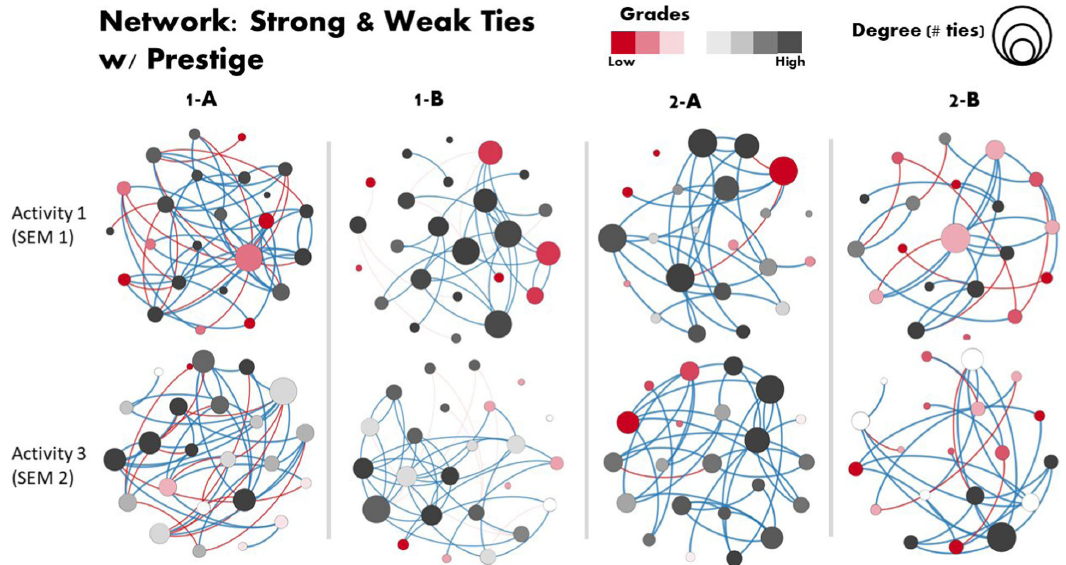
FIG. 6. Strong and weak collaboration network with academic prestige on activities 1 (end of semester 1) and 3 (end of semester 1) for each class. Node color represents academic performance from low (red) to high grades (black); size of nodes indicates degree centrality — number of collaborative ties; edges ’ colors indicate strong ties (blue) and weak ties (red) with proficient students. Note that by default isolates are set to the size of the lowest